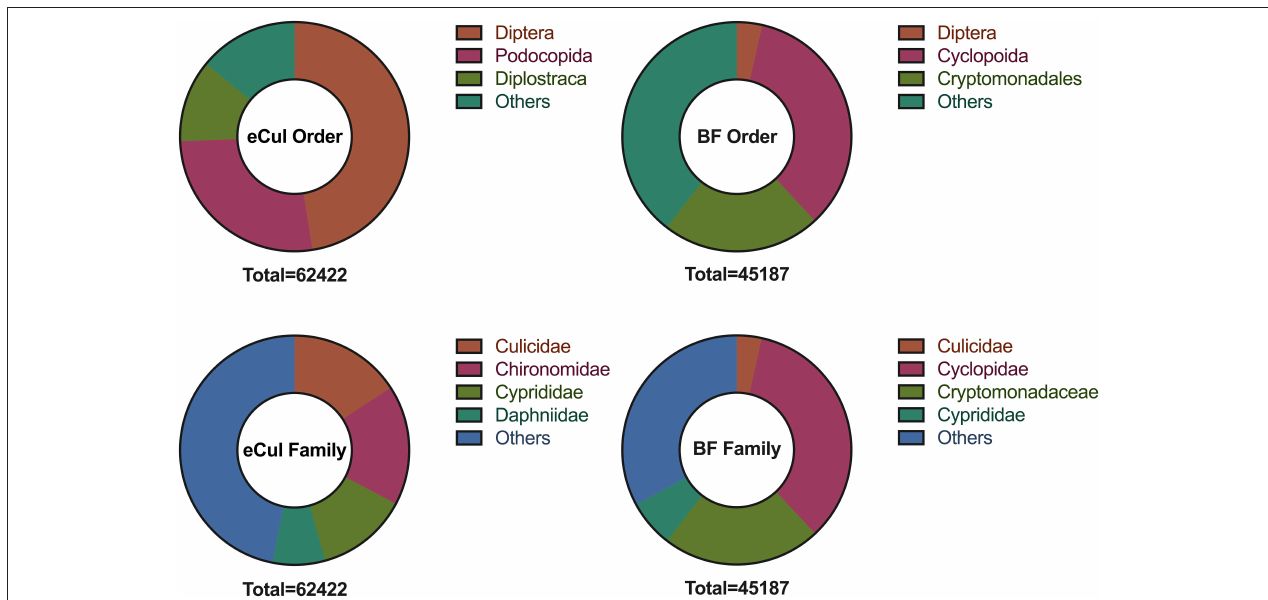
FIGURE 3 | Taxonomic range as picked-up by the BF1/BR1 (BF) eCul-F/eCul-R (eCul) primers, from the eDNA field samples, expressed in number of reads (total number of reads below each pie chart). Note that the number of reads represents the post-PCR distribution, and not the taxa abundance. The BF primers picked up a wide range of unrelated taxa, whereas the eCul primers picked up a narrow range of related taxa, most of which belonged to families within the infraorder Culicomorpha (order: